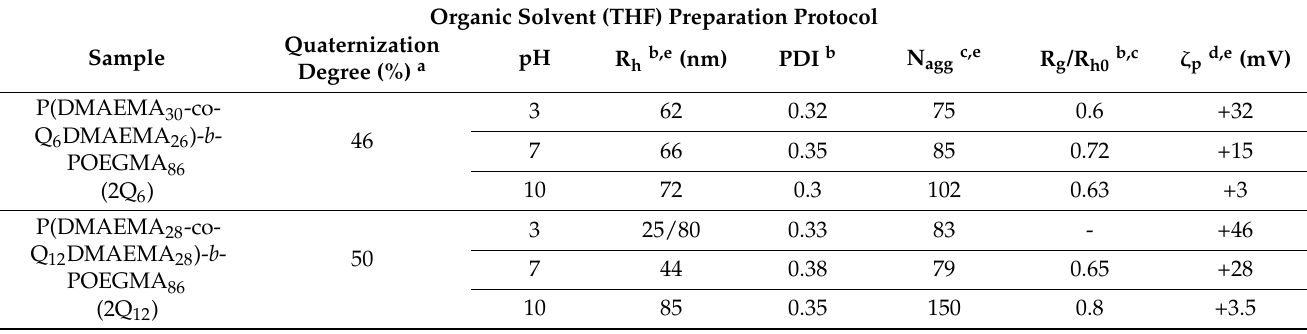
Table 4. Physicochemical characteristics of the P(DMAEMA 30 -co-Q 6 DMAEMA 26 )- b -POEGMA 86 and P(DMAEMA 28 - co-Q 12 DMAEMA 28 )- b -POEGMA 86 diblocks at different pHs, from organic solvent protocol and solution concentration c = 1 × 10 − 3 g/mL. Organic Solvent (THF) Preparation